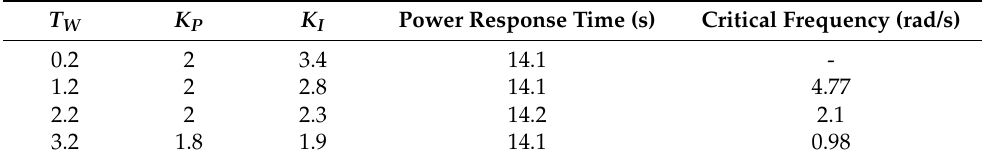
Table 2. The parameters in power regulation mode (PRM).